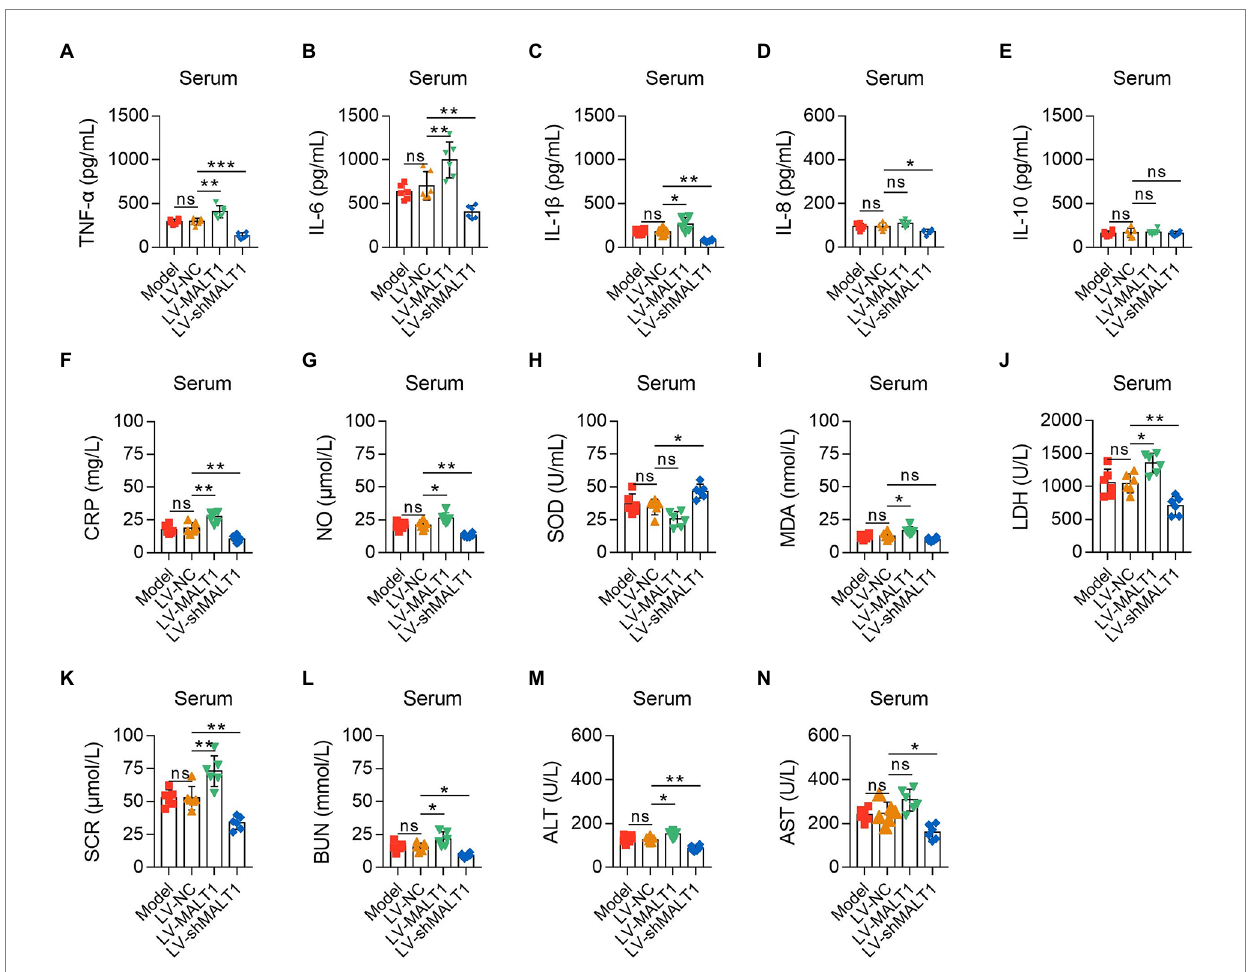
FIGURE 5 Effect of MALT1 on inflammation, oxidative stress, and liver and kidney function indexes in LPS-induced septic mouse model. Comparison of TNF- α (A) , IL-6 (B) , IL-1 β (C) , IL-8 (D) , IL-10 (E) , CRP (F) , NO (G) , SOD (H) , MDA (I) , LDH (J) , SCR (K) , BUN (L) , ALT (M) , and AST (N) in the serum among the Model, LV-NC, LV-MALT1, and LV-shMALT1 groups. n = 6 in each group. One-way ANOVA plus Tukey’s post hoc test was applied. Ns, not significant; * p < 0.05; ** p < 0.01; *** p <